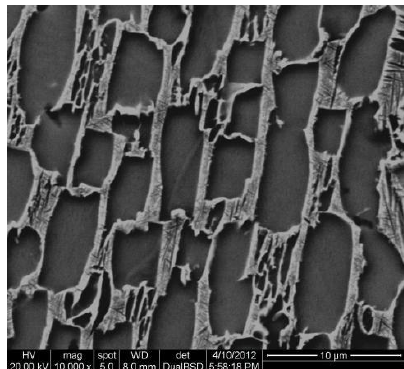
Figure 1. Basketweave microstructure of TC21 titanium alloy after polishing.